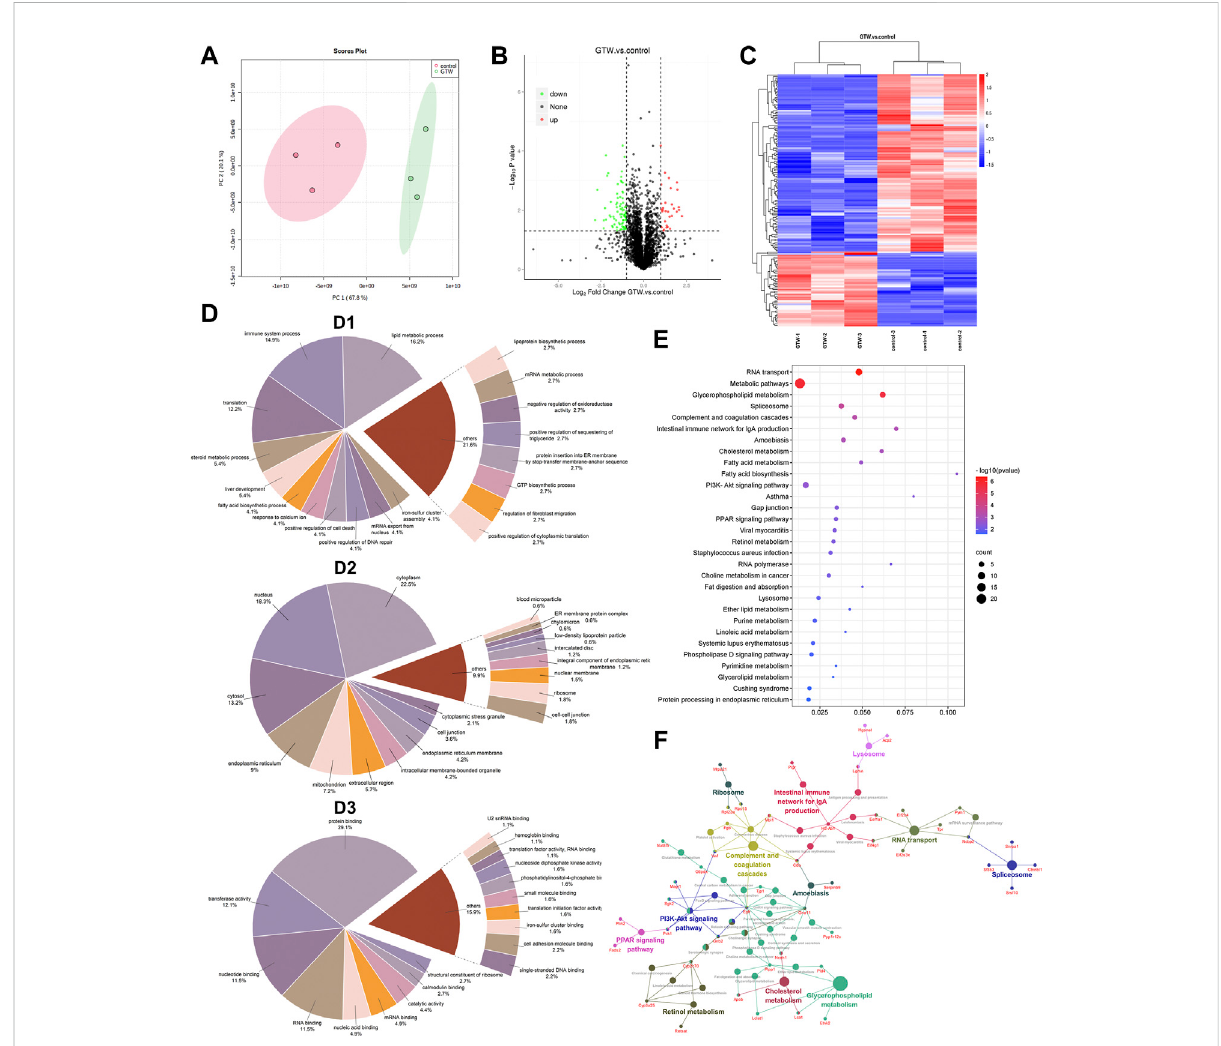
FIGURE 3 Results of proteomics combined with bioinformatics analysis of mice livers after GTW exposure. (A) PCA analysis of identi fi ed proteins. (B) Volcanoplot.Proteinsupregulatedordownregulatedwerepresentedasredorgreenpoints,respectively,andblackpointsrepresentedproteinswith no signi fi cant changes (|log2FC| ≥ 1 and p < 0.05). (C) Heatmaps of DEPs. Rows represented DEPs and columns represented samples with three biological replicates. The signal values of DEPs were shown as colored bars, that is, the high expressed DEPs were colored in red, and the